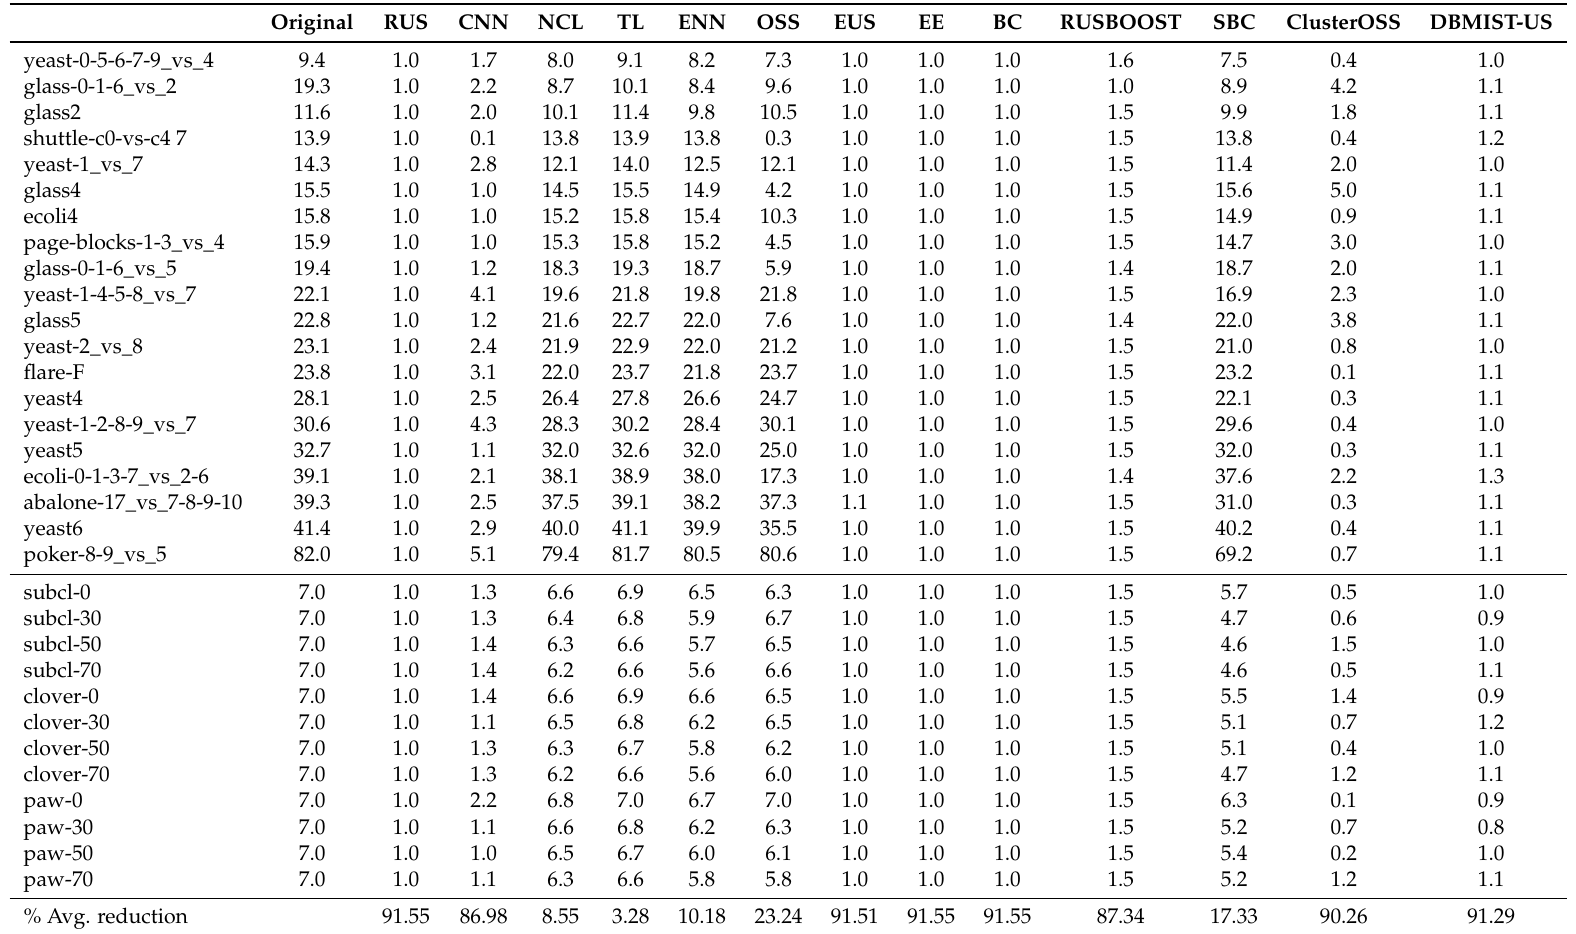
Table 4. Imbalance ratio of the resampled data